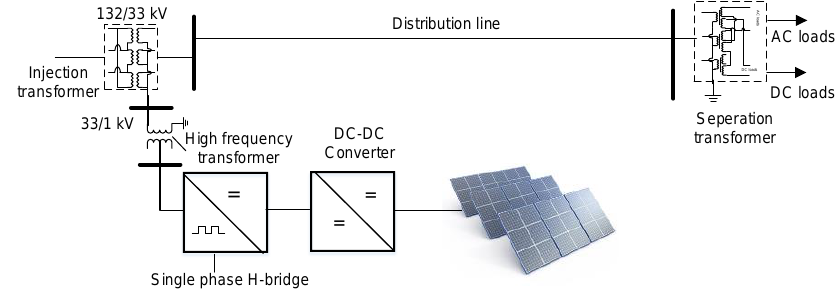
Figure 2: Proposed connection of a large PV array to the distribution